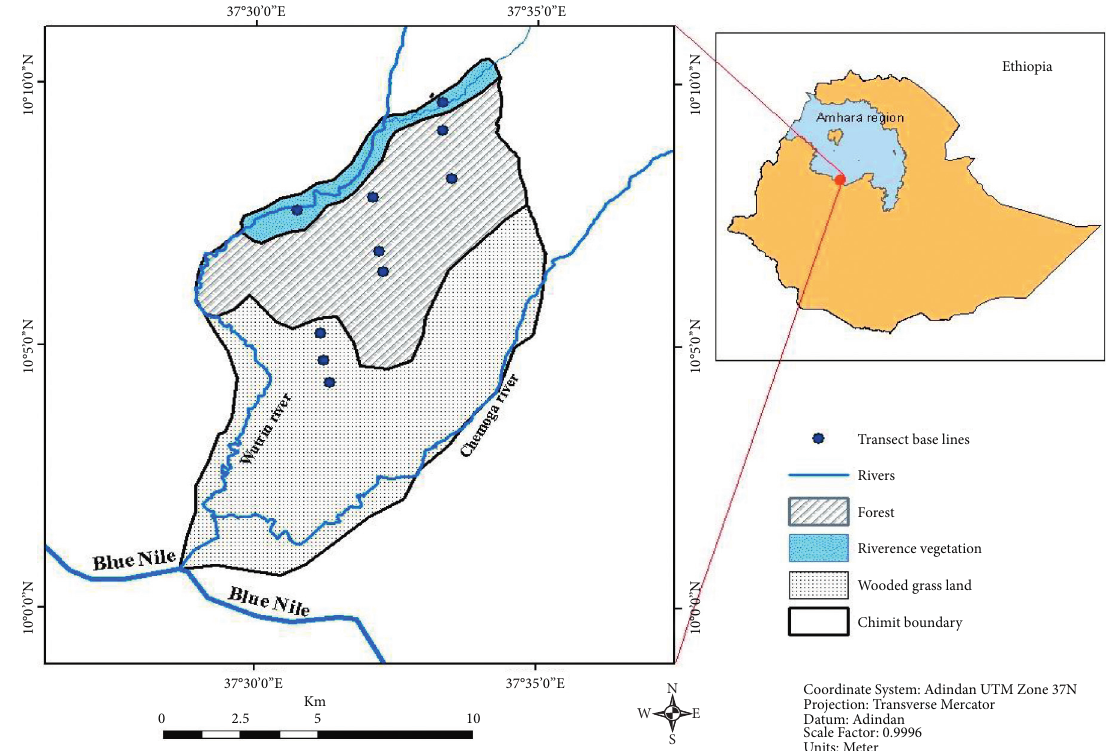
Figure 1: Map of